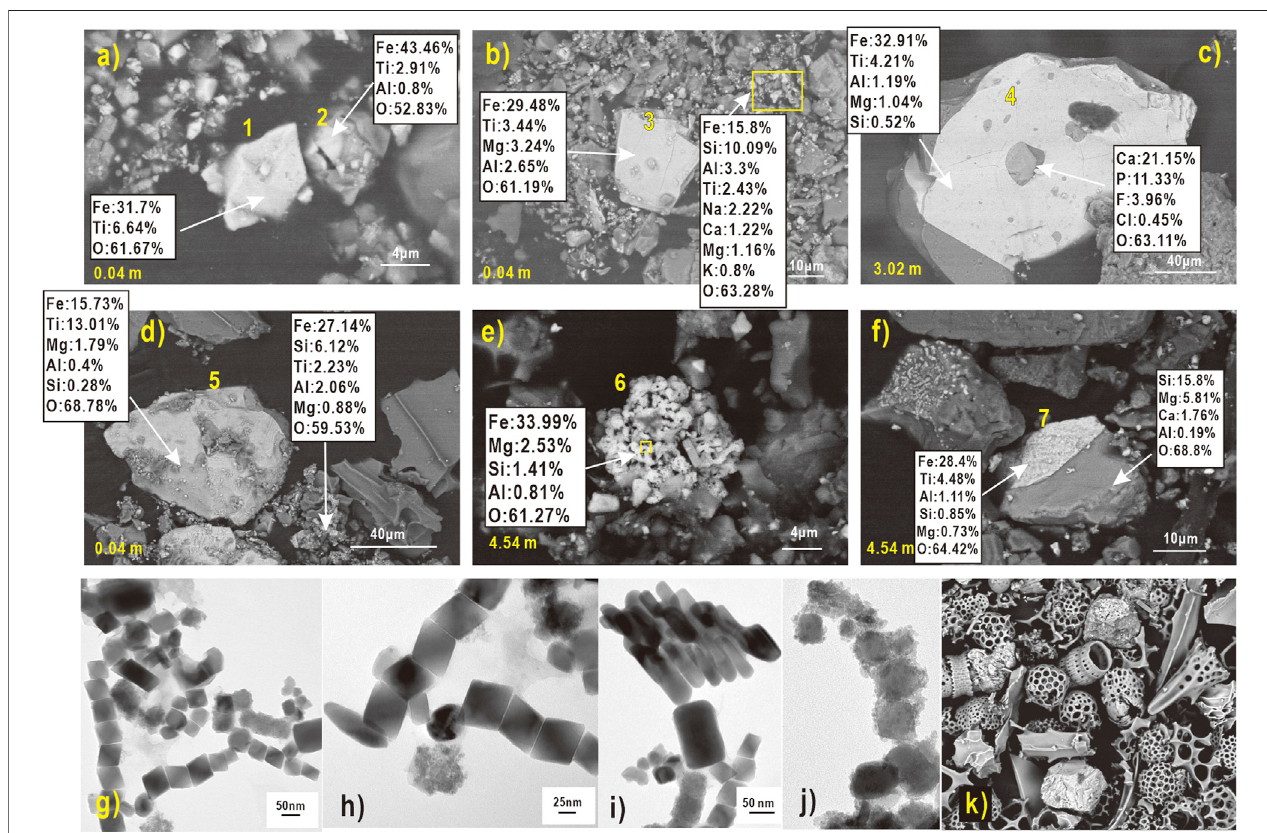
FIGURE 4| SEM and TEMmicrographs of magnetic extracts from selected SO264-19-2 samples. Respectivecore depths(m) and particle numbers are shown in yellow (A – F) : SEM images of large volcaniclastic Fe-Ti oxide minerals with EDX element concentrations [atomic%] (G – J) : TEM images of chains and clusters of fossil bacterial magnetosomes of octahedral, prismatic and elongated shapes and various sizes. (K) SEM image of radiolarian skeletons and diatom frustules.